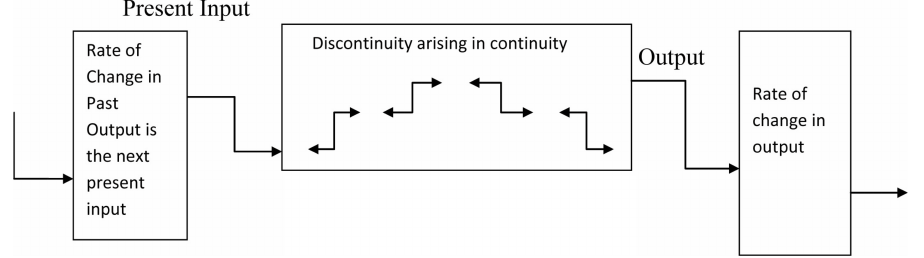
Figure 3. Scheme of the hybrid neutral delay